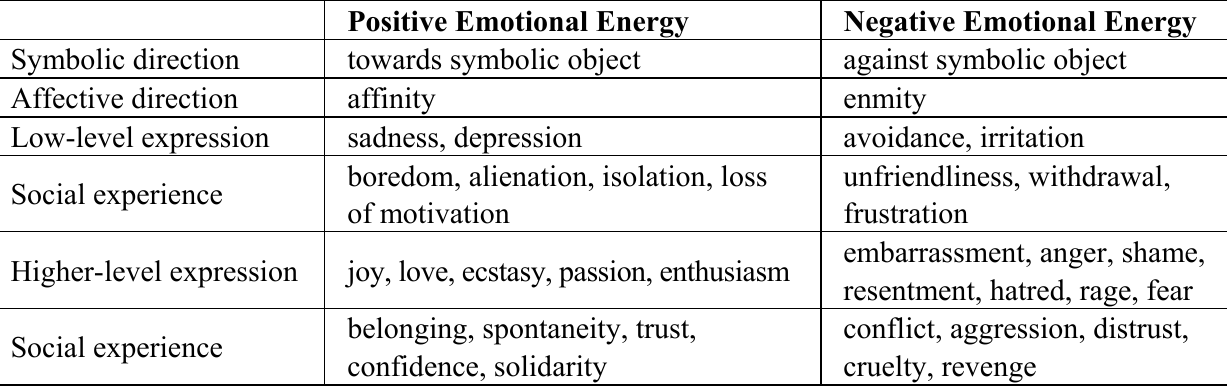
Table 2. Analytical distinction between positive and negative emotional